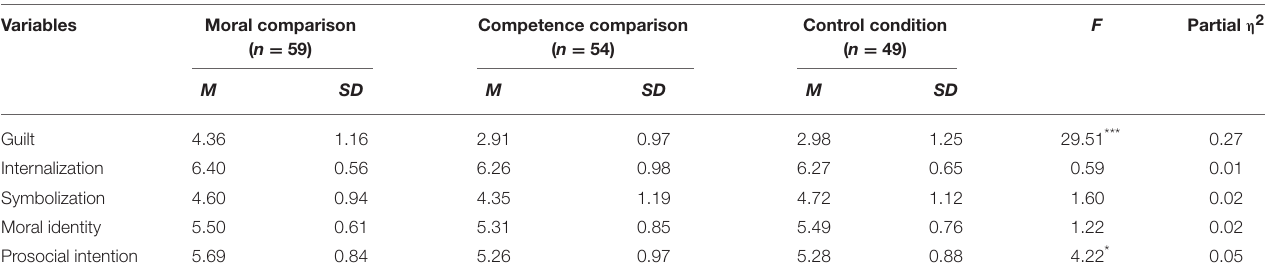
TABLE 2 | One-way ANOVA comparing the three conditions ( N = 162).